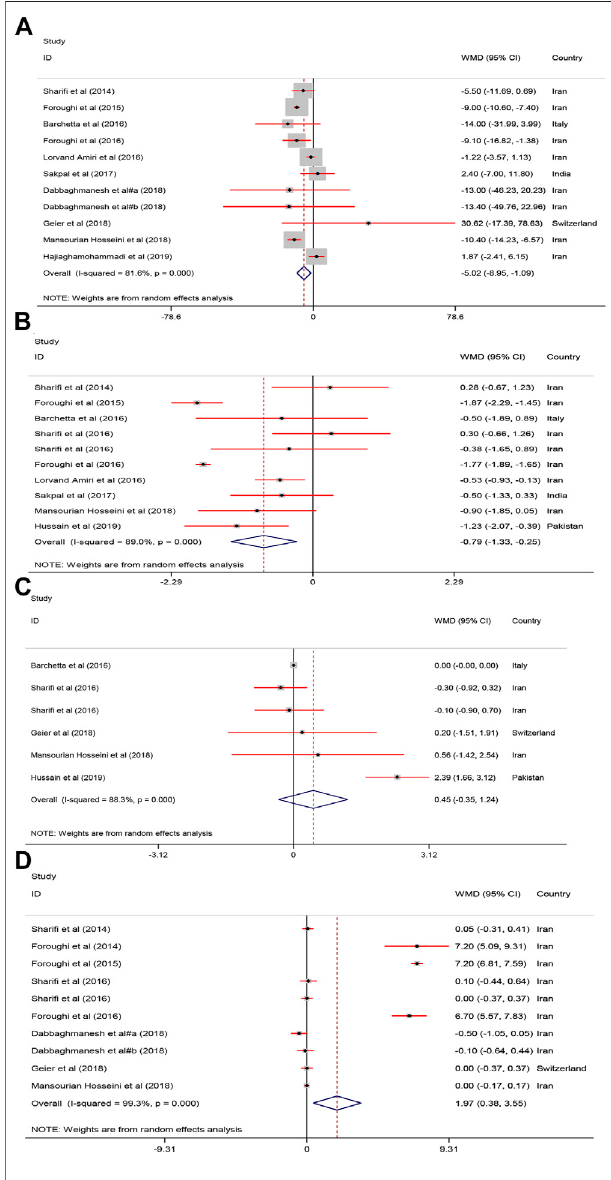
FIGURE 5 | The FBS, HOMA, Adiponectin and calcium mean differences estimates for (A) FBG, (B) HOMA − IR, (C) Adiponectin and